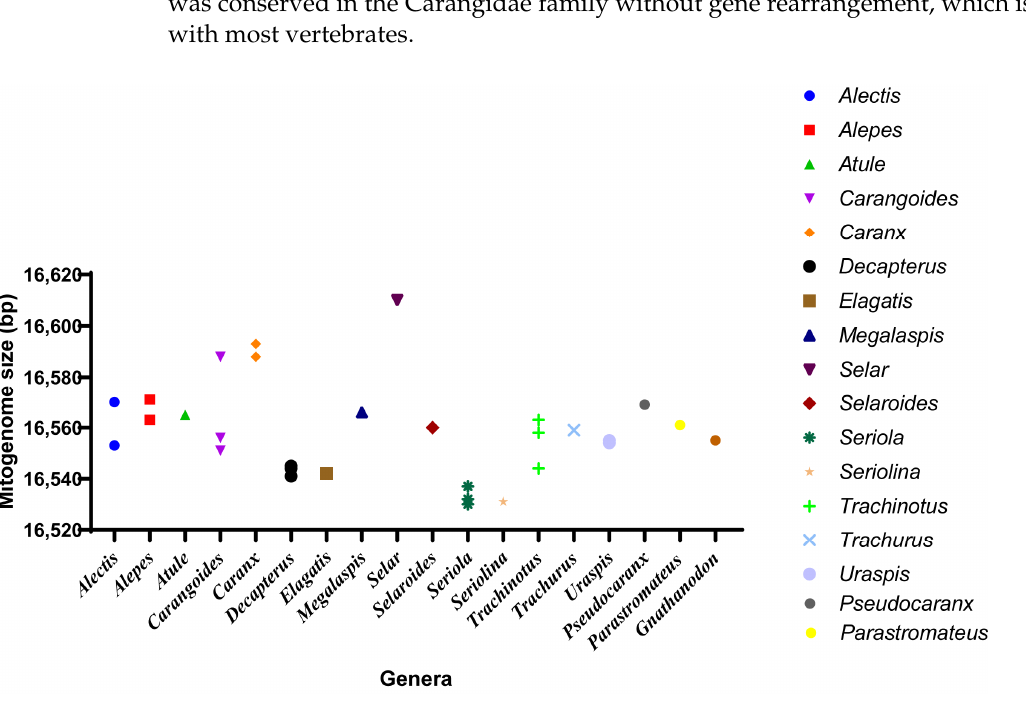
Figure 7. Mitogenome size distribution of Carangidae fishes. Thirty-six species from eighteen genera obtained from GenBank were displayed.